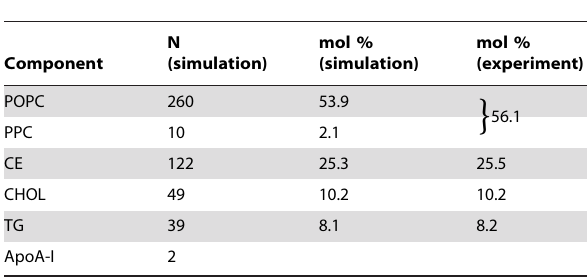
Table 1. Molecular composition of